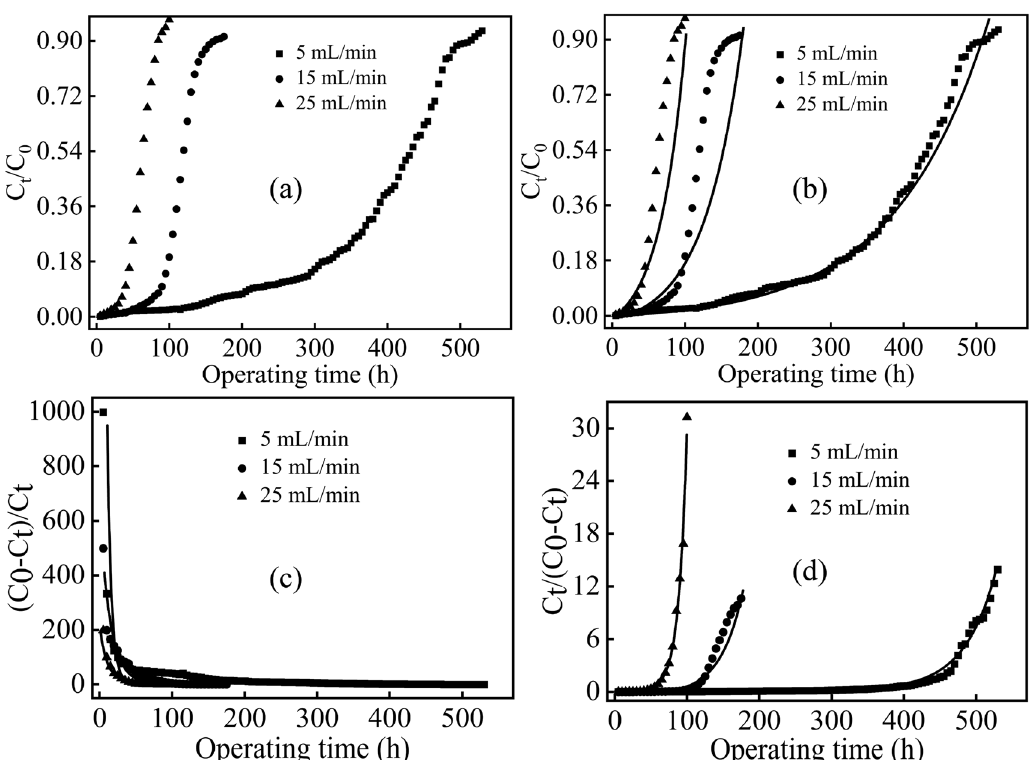
Figure 9: In fl uence of the in fl uent fl ow rate on the breakthrough curves of the treatment of MG dye from aqueous solutions using ceramsite - supported nZVI in a fi xed - bed reactor ( a ) , and the fi tting results of Thomas ( b ) , Y – N ( c ) , and A – B ( d ) fi xed - bed reaction kinetic models.